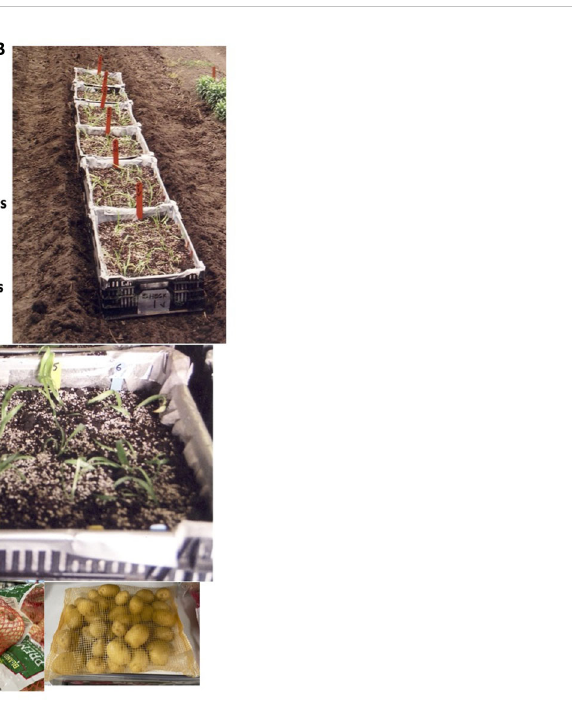
FIGURE 1 (A) View of a mature Easter lily plant indicating location of the parts analyzed in the trials: foliage (visually rated), bulblets (counted and weighed), stem roots (visually rated), bulb (weighed), and bulb roots (visually rated). (B) View of perforated plastic crates used in Trial 1. To be certain that all plantlets could be recovered, we modi fi ed a standard technique used in the greenhouse of planting in perforated plastic crates and then planted the crates in the fi eld. The crates were placed in fl at bottomed furrows in the fi eld either in nontreated soil or in soil that had been previously fumigated. Soil from the same treatment was later fi lled in around the crates. Photo is of the six crates placed in untreated soil. Half of the crates were later treated with an organophosphate. (C) View of a single plastic crate with three plants of each lily type planted in a row identi fi ed by colored stakes: NTrNW (white), CYS 11 (red), CYS 25 (orange), CYS 55 (green), CYS 59 (yellow) and CYS 71 (blue). (D) Mesh bags of the type used to hold plants and bulbs for individual replicates prior to dipping in a preplant fungicide bath and then planting in the fi